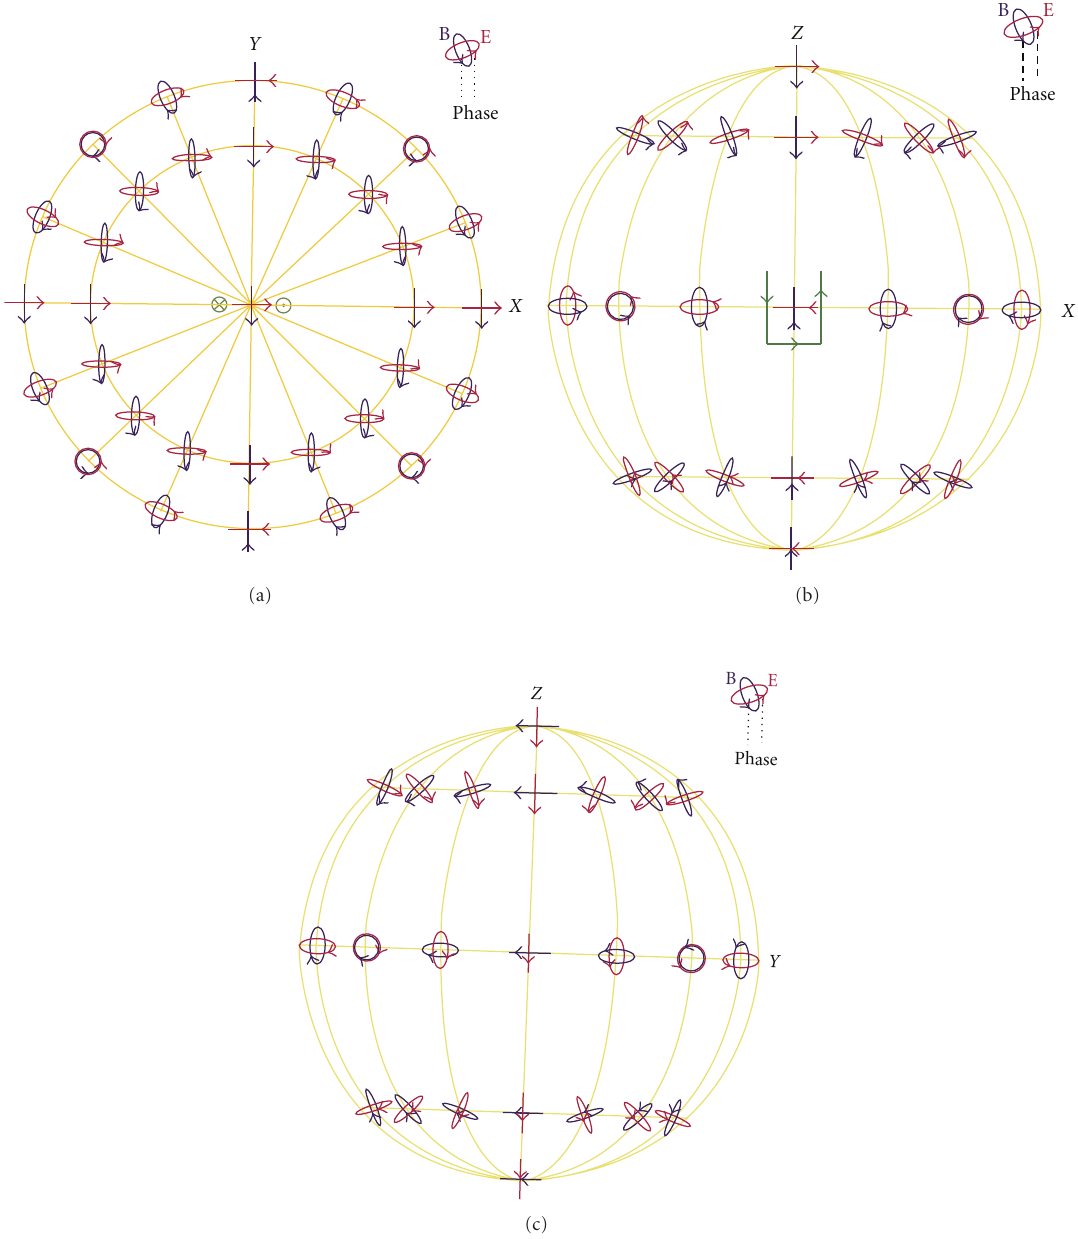
Figure 4: (a) Schematic view of an observer, of the far-field polarization of the U-shaped power isotropic radiator at the angles θ = 0, π/ 4, π/ 2, and at multiples of π/ 8 of the angle ϕ. The observer looks into the direction of the negative Z -axis. The polarizations have been drawn by rotating them so that they appear perpendicular to the line of sight. The green drawing represents the direction of the current of the radiator at a given time. The red ellipses represent the electric field, while the blue ellipses the magnetic field. The tip of the arrow (in black) indicates the phase for a given time, and the arrow points in the direction of the rotation of the fields. (b) Similarly as in Figure 4(a), but here the observer looks into the direction of the Y -axis, and the polarizations are drawn for θ = 0, π/ 4, π/ 2,3 π/ 4, π , and ϕ is between − π/ 8 and − 7 π/ 8 in multiples of π/ 8. (c) Similarly as in Figure 4(a), but here the observer looks into the direction of the negative X -axis, θ = 0, π/ 4, π/ 2,3 π/ 4, π and ϕ = 0, ± π/ 8, ± π/ 4, ± 3 π/